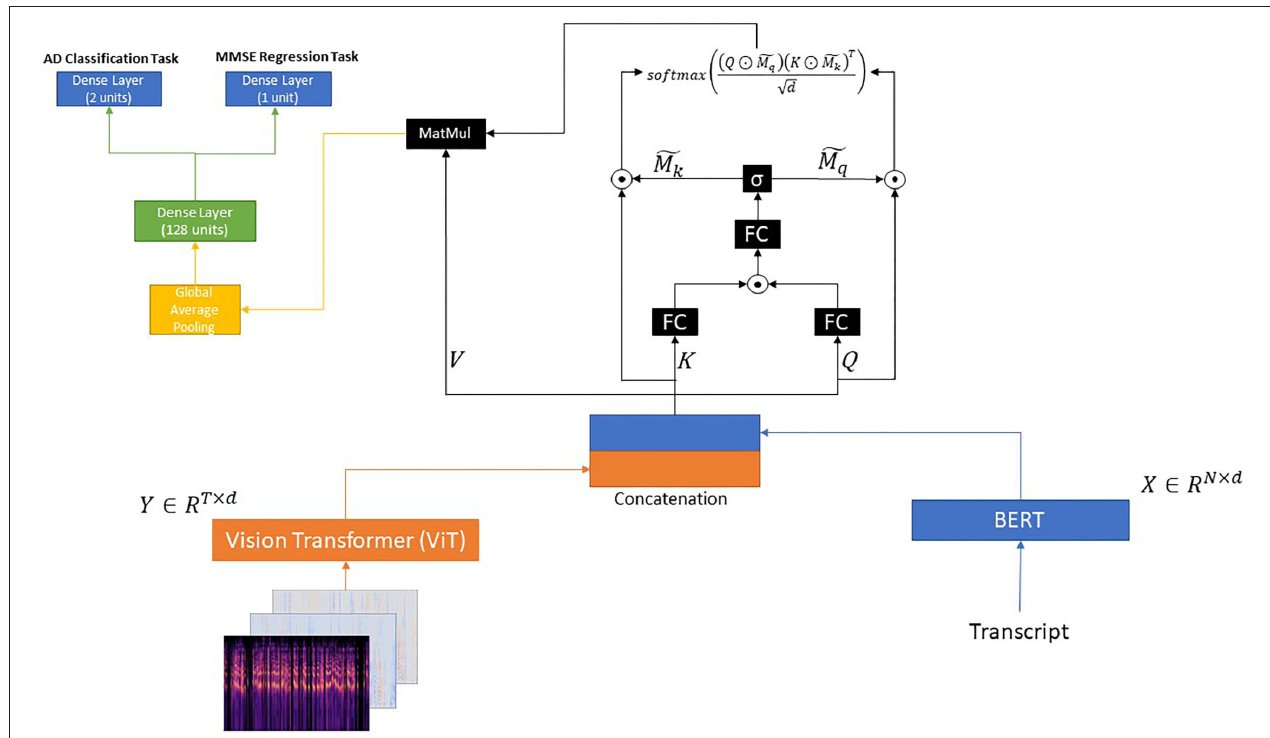
FIGURE 3 | BERT + ViT + Gated